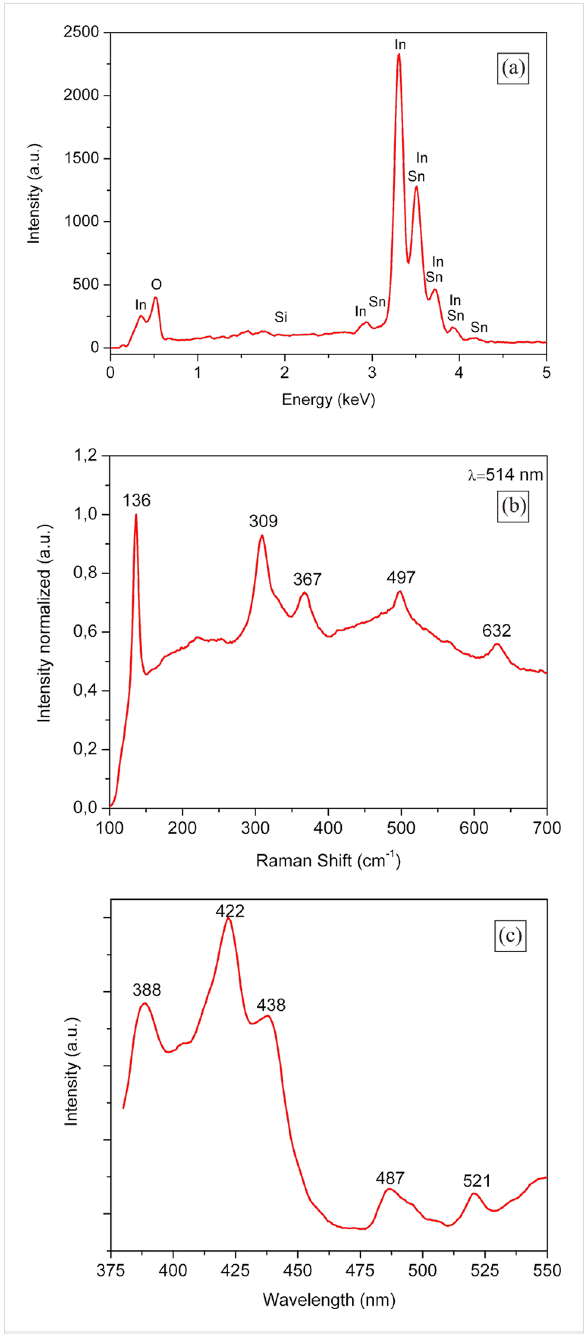
Figure 3: (a) EDX spectrum of ITO-NTs dissected on silicon waver. (b) Normalized Raman Scattering spectrum of the ITO-NTs. (c) Normal- ized PL spectra of the ITO-NTs excited at 270